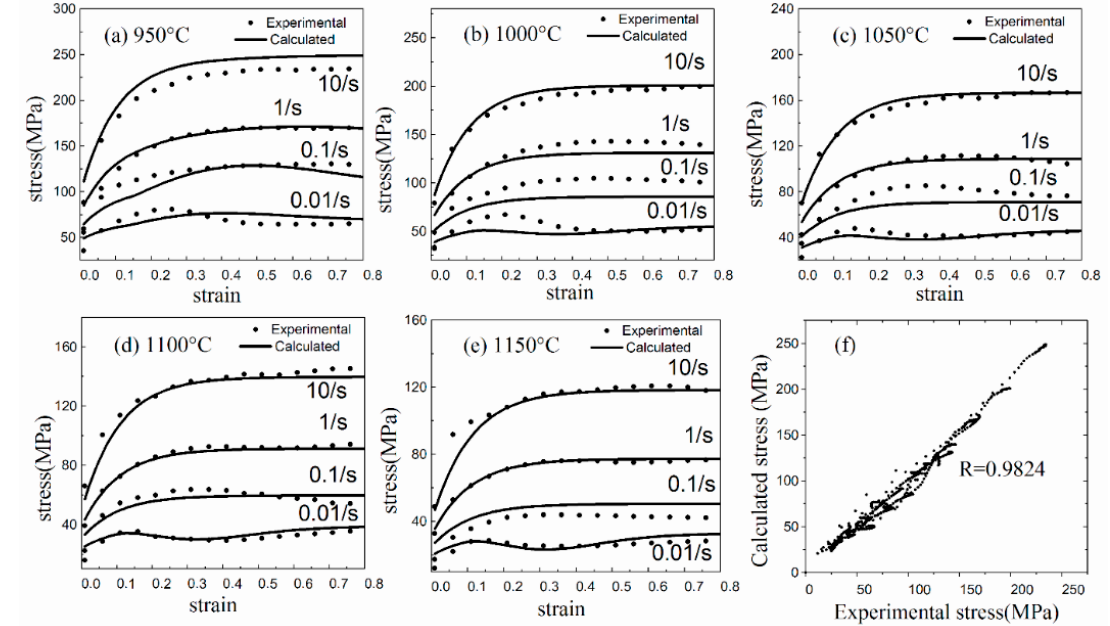
Figure 7. Comparison of experimental and calculated flow stress of 300M steel. ( a ) 950 °C, ( b ) 1000 °C, ( c ) 1050 °C, ( d ) 1100 °C, ( e ) 1150 °C, and ( f ) a scatter plot drawn from experimental and calculated stresses.